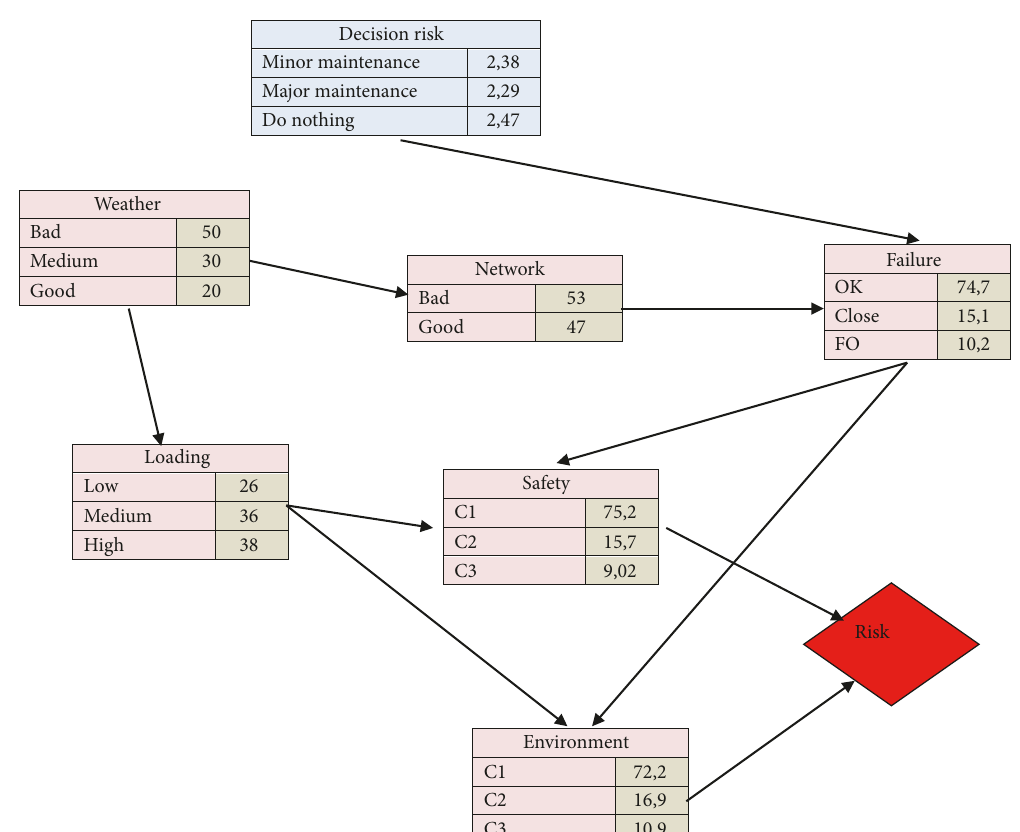
Figure 5: Influence diagram with crisp probabilities.